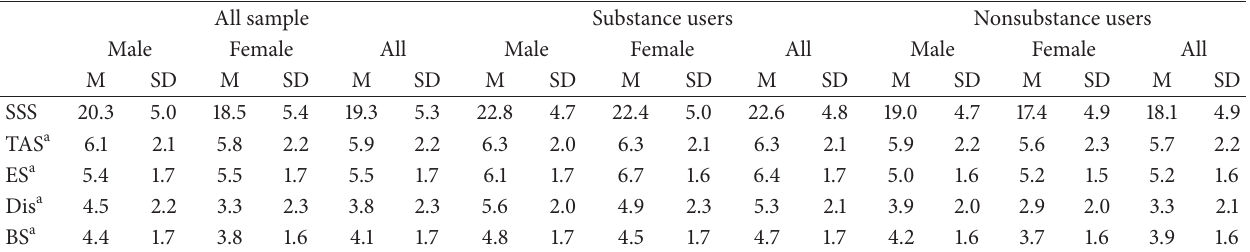
Table 3: Sensation Seeking Scale (SSS) global and subscale mean scores (M) and standard deviation (SD) for the entire sample, for substance users and nonusers adolescents, and for gender.